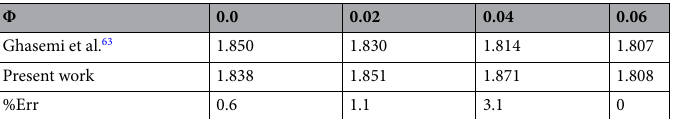
Table 3. Comparison of the average Nu between the present work and that of Ghasemi et al. 63 at different nanoparticle volume fractions.